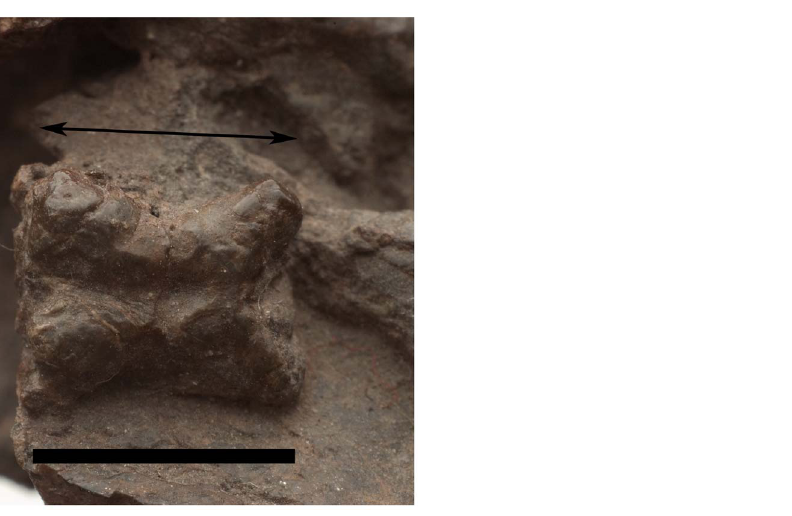
Figure 13. Osteoderm of Pseudochampsa ischigualastensis (PVSJ 567) in dorsal view. The black arrow indicates anteroposterior orientation. Scale bar equals 1